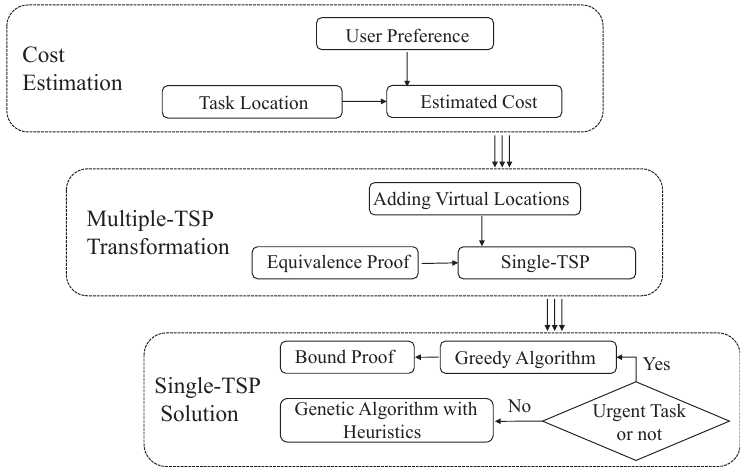
Figure 2. The task allocation system